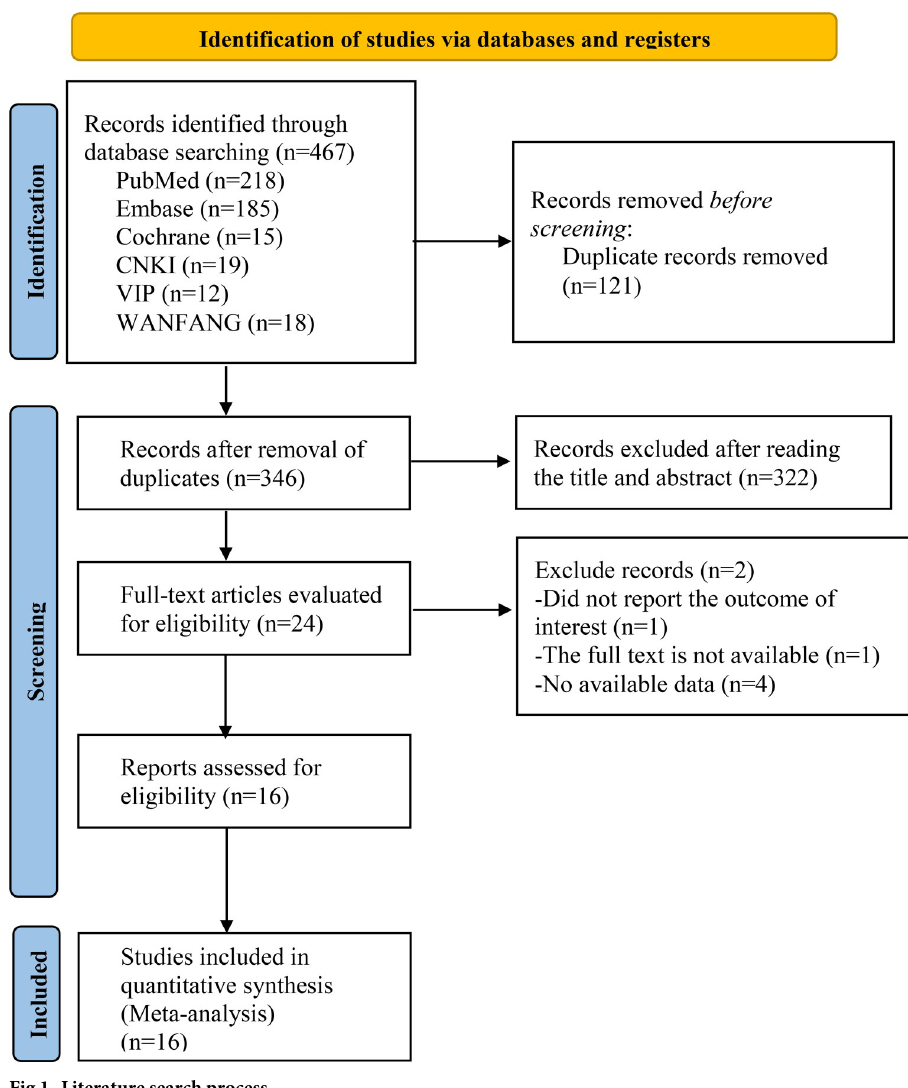
Fig 1. Literature search